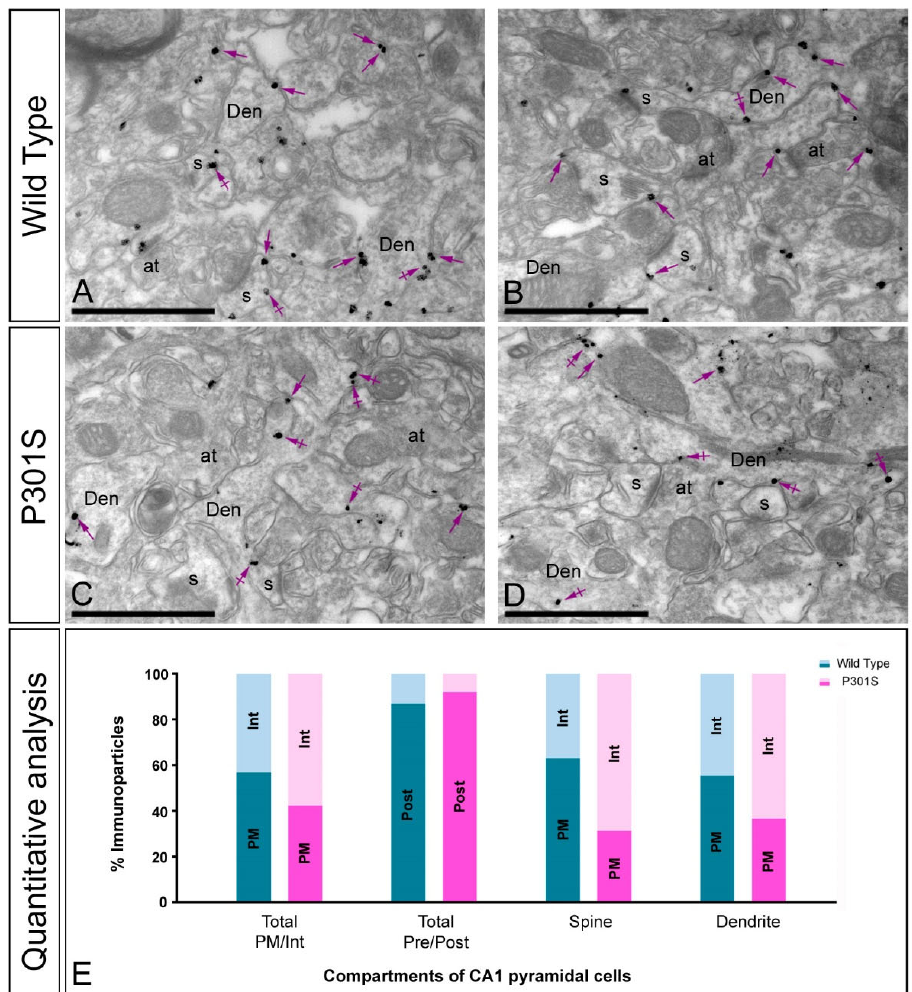
Figure 4. Changes in the postsynaptic localisation of GIRK2 in the hippocampus of P301S mice. Electron micrographs showing immunoparticles for GIRK2 in the stratum radiatum of the CA1 region at 10 months of age in wild type and P301S mice, as detected using a pre-embedding immunogold technique. ( A – D ) In wild type mice, immunoparticles for GIRK2 were mostly located at the extrasynaptic membrane (arrows) of dendritic spines (s) and shafts (Den) of CA1 pyramidal cells, as well as at intracellular sites (crossed arrows). In P301S mice, fewer immunoparticles for GIRK2 were detected along the extrasynaptic membrane (arrows) of dendritic spines (s) and shafts (Den) of pyramidal cells, with more GIRK2 immunoparticles being observed at intracellular sites (crossed arrows). ( E ) Quantitative analysis performed in different compartments of CA1 pyramidal cells showing that immunoparticles for GIRK2 were less frequently observed along the extrasynaptic plasma membrane of dendritic spines and shafts and more frequently at intracellular sites in P301S mice. Scale bars: ( A – D ): 1 µ